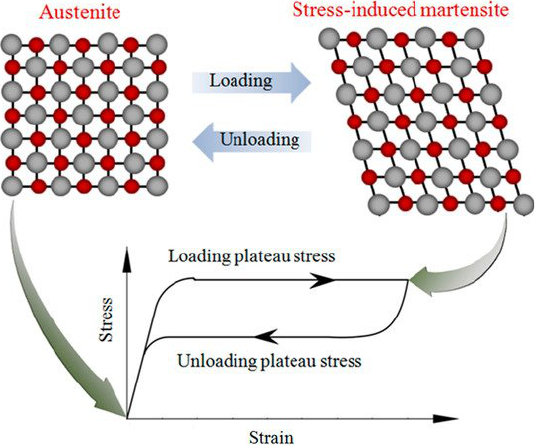
Figure 21. Schematic diagram of crystal structure evolution of NiTi SMA tube subjected to stress- induced martensite (SIM) transformation (Reprinted with permission from Jiang, S., et al. [154]. Copyright 2017, CC BY 4.0 International).